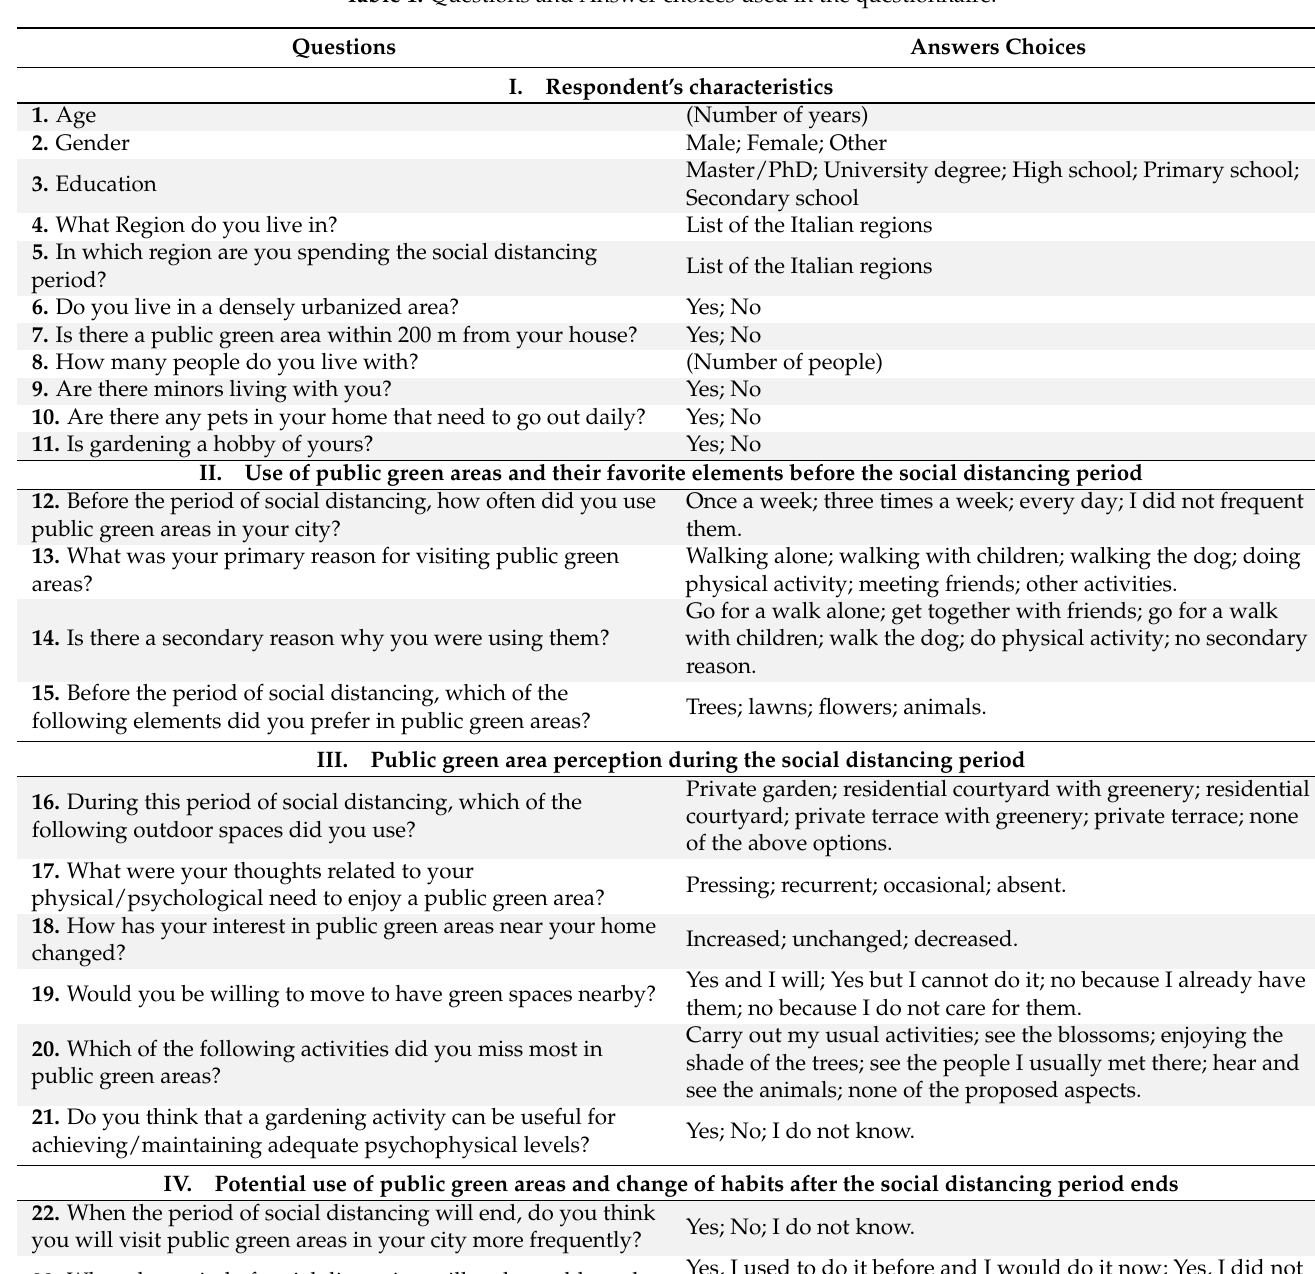
Table 1. Questions and Answer choices used in the